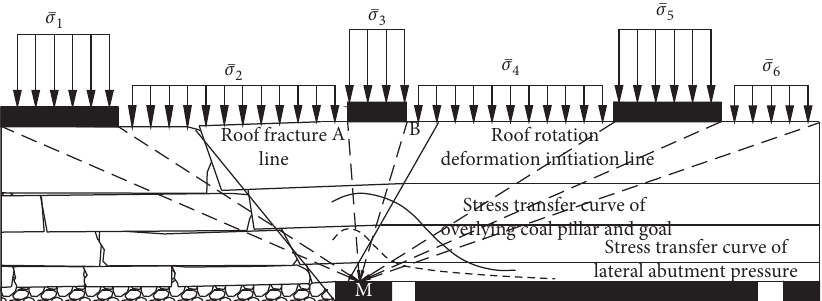
Figure 2: Stress model of working face under overlying coal pillar.